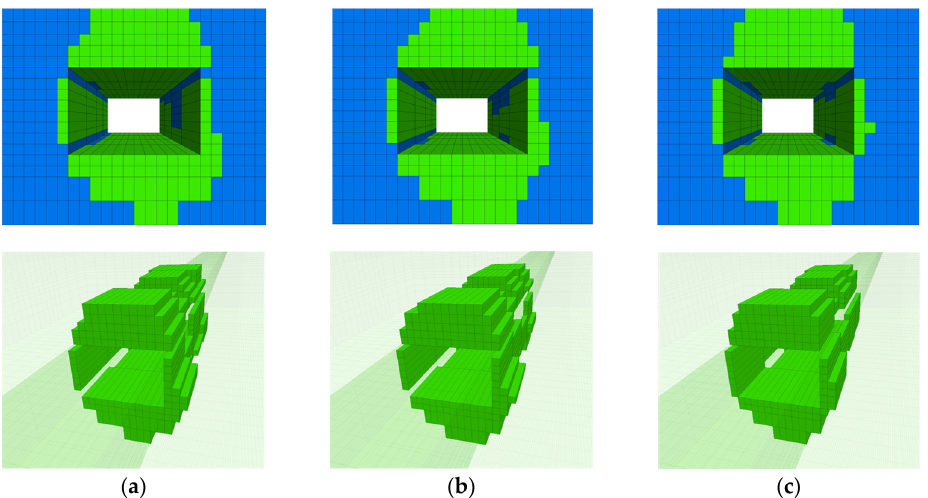
Figure 12. Distribution of tensile failure zones in goaf excavation with different yield pillar widths: ( a ) model—4 m; ( b ) model—6 m; ( c ) model—8 m.